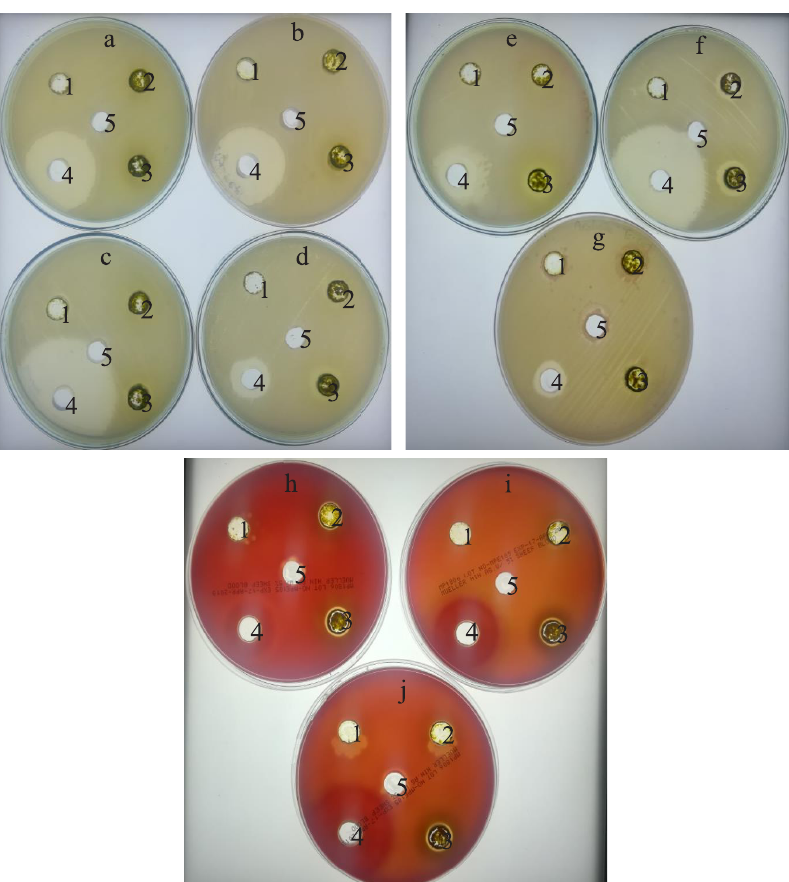
Fig. 1. Antibacterial activity using A. indica extract with acetone against bacterial pathogens a. K. pneumonia b. S. epidermidis, c. E. coli d. S. aureus, e. B. cereus, f. S. typhi, g. S. marcenses, h. S. agalactiae, i. S. dysgalactiae, j. S. pyogenes 1.1mg, 2. 5 mg, 3.10mg, 4.Tetracycline, 5. Negative control